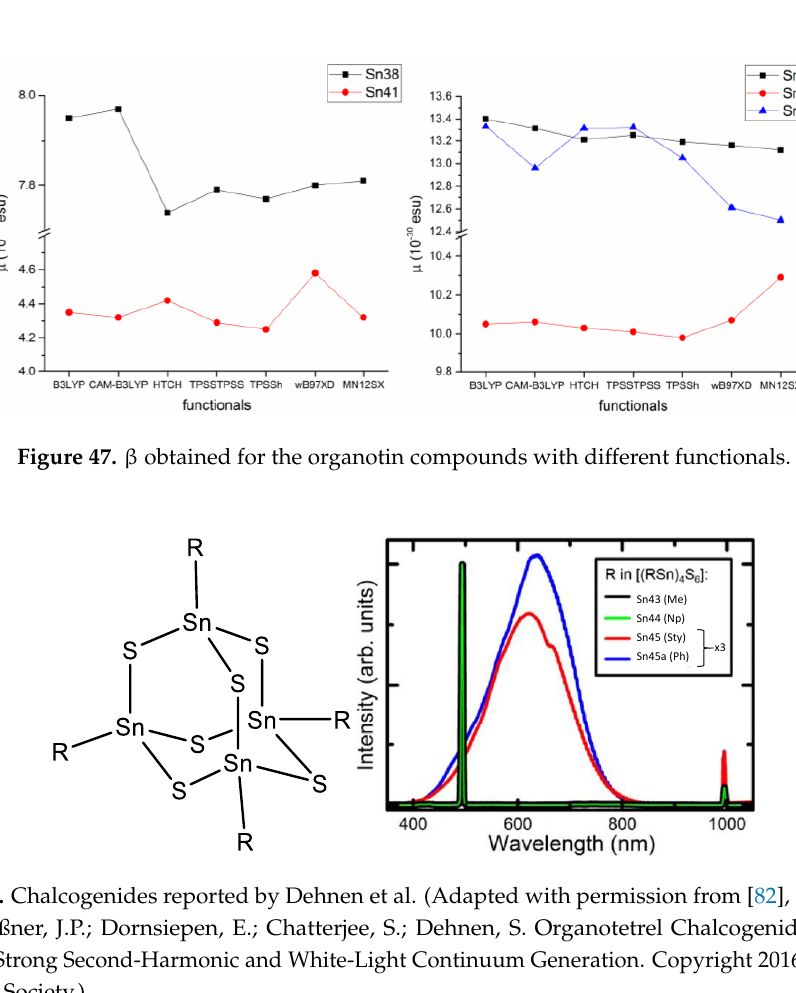
American Chemical Society.) Chemical